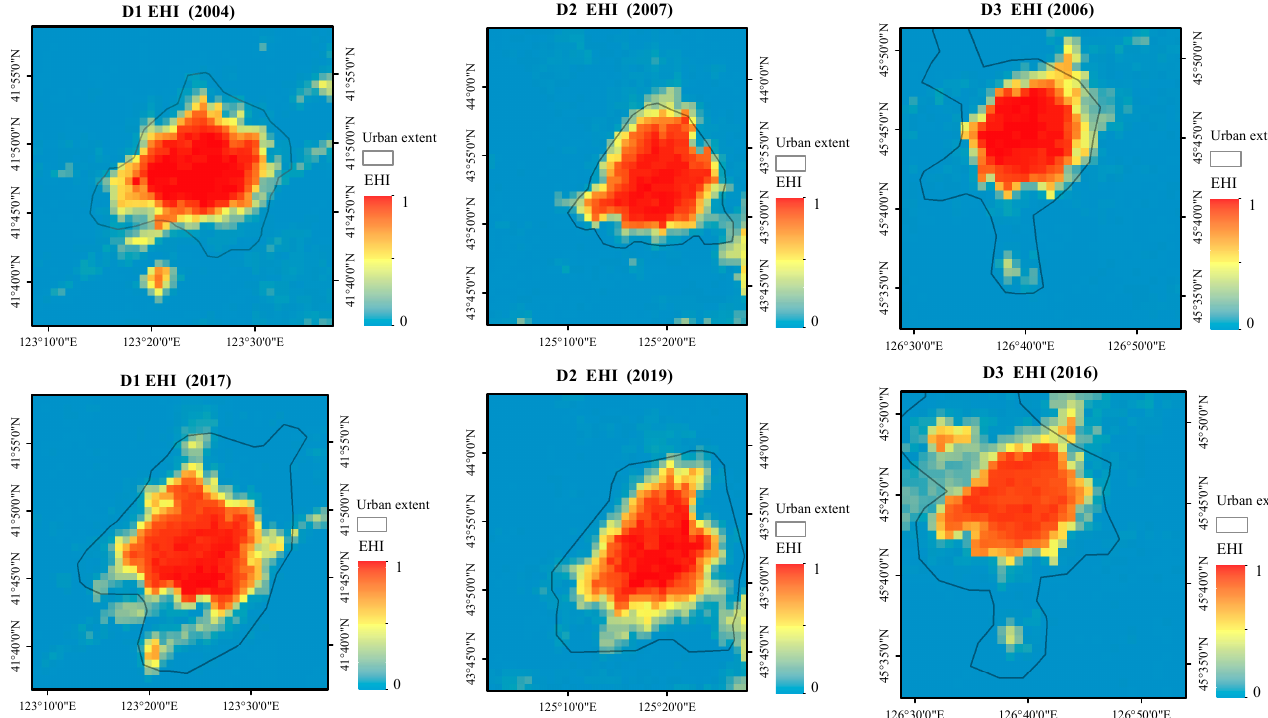
Figure 5. The spatial distribution of the equivalent heat island index (EHI) in the three study areas.